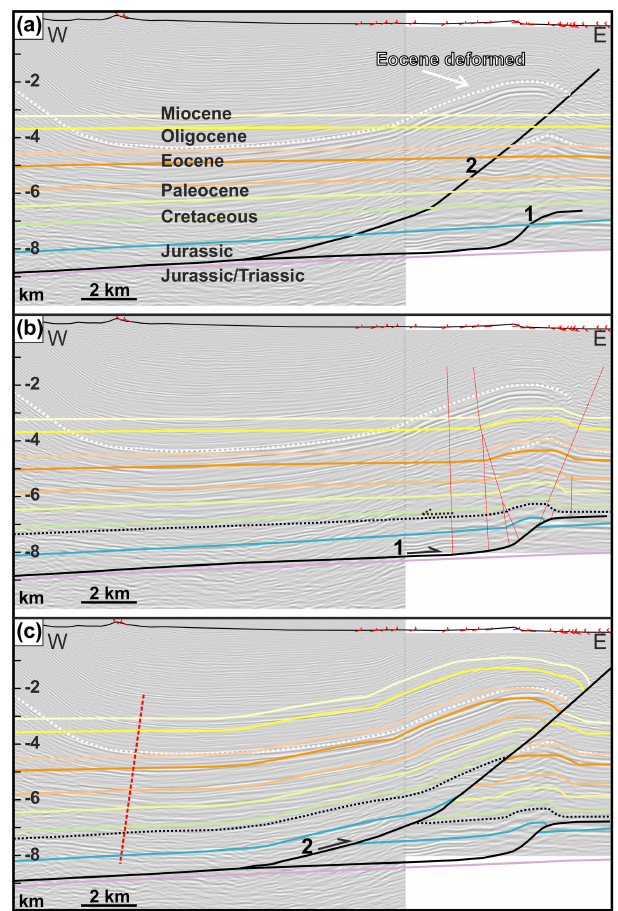
Figure 11. Forward modelling of the frontal structures in the south- ern sector. (a) The seismic image, surface geometry including dips, the present-day deformed state of the top Eocene limestones (con- strained by nearby well control), and the interpreted and constructed faults are given as a reference frame for the forward model. The model uses a stratigraphic wedge with thicknesses which are con- strained by well and outcrop observations. (b) A small triangular structure at the deformation front is modelled with fault-bend fold- ing. The lower detachment (1) is in Lower Jurassic or Triassic suc- cession, and the upper one is interpreted in the soft Cretaceous Goru shales (dotted line). (c) A fault-propagation fold forms hinterland- ward of the triangular structure by a thrust ramp (2) modelling done with tri-shear. The model mimics the structure imaged in the seis- mic section approximately from the deformation front (east) to the red stippled